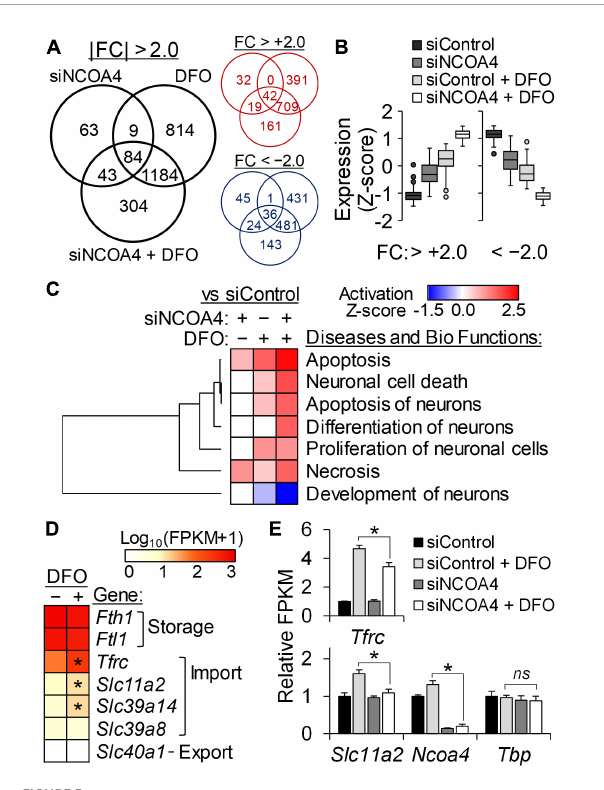
FIGURE5 Transcriptome analysis reveal a protective role of NCOA4 against apoptosis induced by neuronal iron deficiency. Transcripts responsive to NCOA4 depletion by siRNA (siNCOA4), iron deficiency (DFO), and a combination of the two (siNCOA4 and DFO) were identified by RNA-seq ( n = 3 biological replicates). DFO was treated at 100 µ M for 24 h. (A) Numbers of differential expressions shared by or exclusive to each treatment are shown in the black Venn diagram. Transcripts with | FC| > 2.0 and FDR-adjusted P < 0.05 vs control siRNA (siControl) were considered DE. Venn diagrams in red and blue indicate the numbers of upregulated and downregulated genes, respectively, by each treatment. (B) Expression pattern of DE genes exclusively identified in cells treated with siNCOA4 plus DFO. For each gene, expression values of all treatment groups were standardized by Z-score transformation to yield a mean of zero and SD of one. (C) Comparisons among the IPA activation Z-scores of neuron-related Diseases and Bio Functions by genes responsive to siNCOA4, DFO, and siNCOA4 plus DFO. IPA core analyses was performed for DE by each treatment (vs siControl), and further analyzed by comparison analysis. Neuron-related Diseases and Bio Functions with significant activation Z-scores by siNCOA4 plus DFO vs siControl are shown ( P < 0.05). (D) Relative transcript abundance of genes for cellular iron homeostasis determined by RNA-seq FPKM. Gene expression data was ranked by mean FPKM values of siControl cells, and presented as Log 10 (FPKM + 1). * P < 0.05 by DFO. (E) Less Tfrc and Slc11a2 transcript responses to iron restriction in NCOA4-depleted cells. Data are shown as mean ± SD of FPKM from n = 3 biological replicates. * P < 0.05 by NCOA4 depletion; ns, not significantly